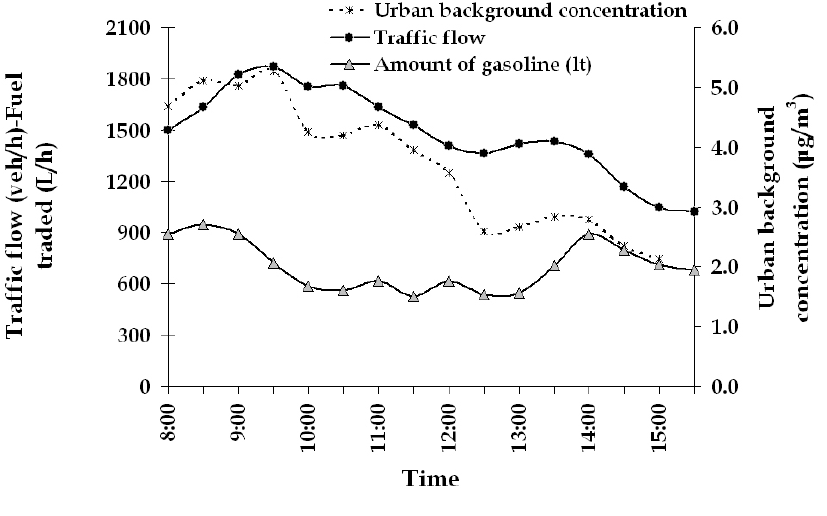
Figure 5 . Averaged weekly daily variation of traffic flow (in veh/h), fuel traded (in lt/h) and urban background concentration (in μ g/m 3 ) of the urban filling